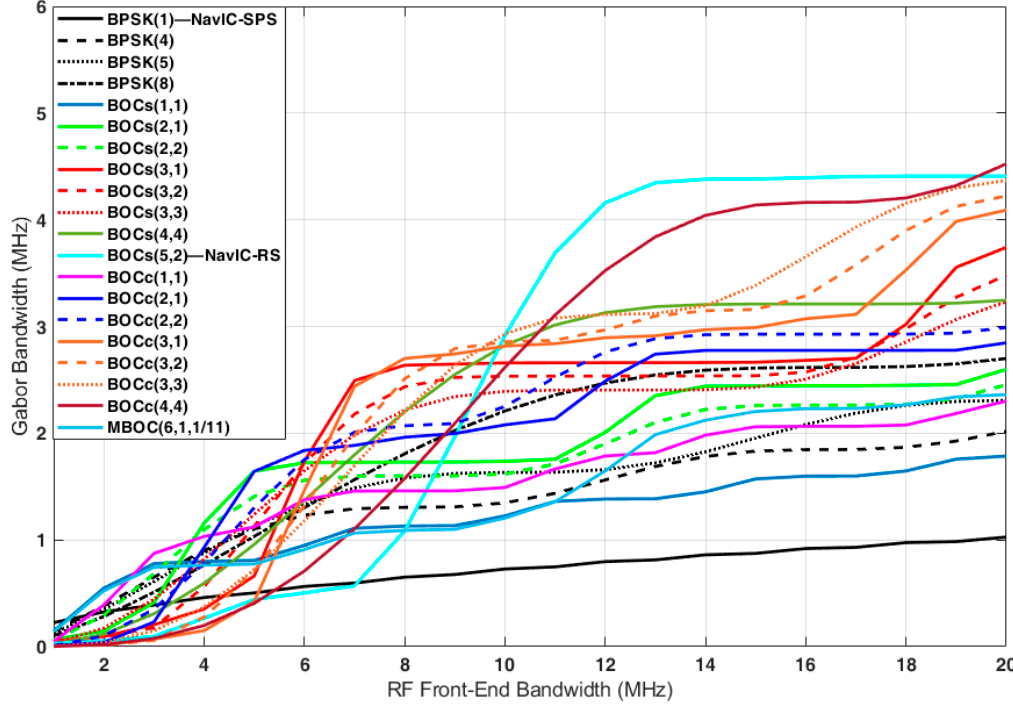
Figure 4. Gabor bandwidth of the candidates in the S-band.